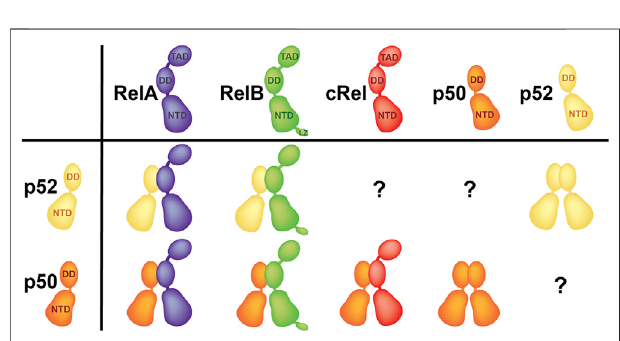
FIGURE 3 | Preferential dimers. p52:RelB and p52:RelA heterodimers, aswellasthep52:p52homodimerarethethreep52dimershavebeenseenin cells. p50 is the only subunit which forms four out of fi ve possible